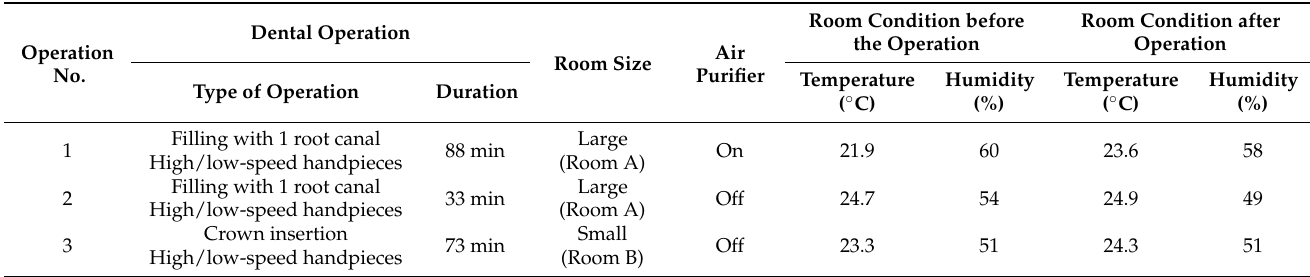
Table 2. Dental operation conditions for tests with real patients in room.